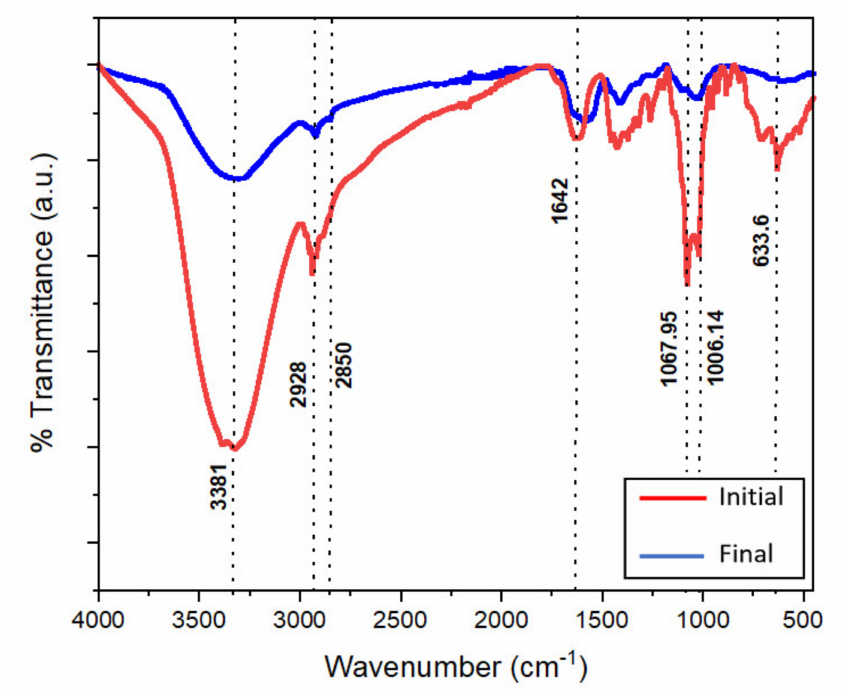
Figure 5. FTIR spectrophotometry of the initial and final papaya waste. Table 1 shows the results from the BLAST characterisation of the DNA sequence from isolated bacteria at the microbial fuel cell anode. The use of the ribosomal ribonucleic acid (rRNA) 16S is the best method for bacterial identification, providing phylogenetic information from sequencing analysis [47]. By comparing the results to the database, identity percentages of 99.32% for Achromobacter xylosoxidans , 99.93% for Acinetobacter bereziniae , and 100.00% for Stenotrophomonas maltophilia were obtained. Xue et al. (2017) reported a biocathode’s bacterial diversity of a microbial combustion cell for the Cr (VI) reduction in tannery effluents where the authors emphasise the classes of Stenotrophomonas